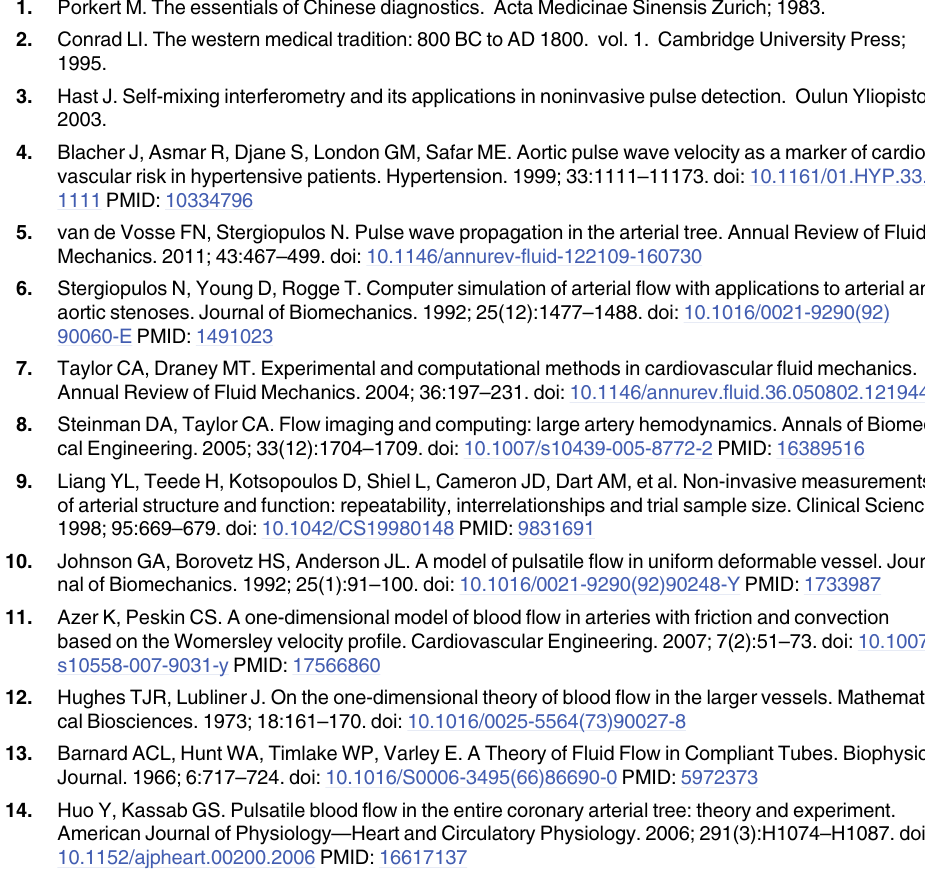
S1 Fig. The blood flow rate measured in the ascending aorta experimentally. ω = k ω . The blood flow rate is measured by an automated contour tracing of the right panel is ω k 0 method in the work of Ref.